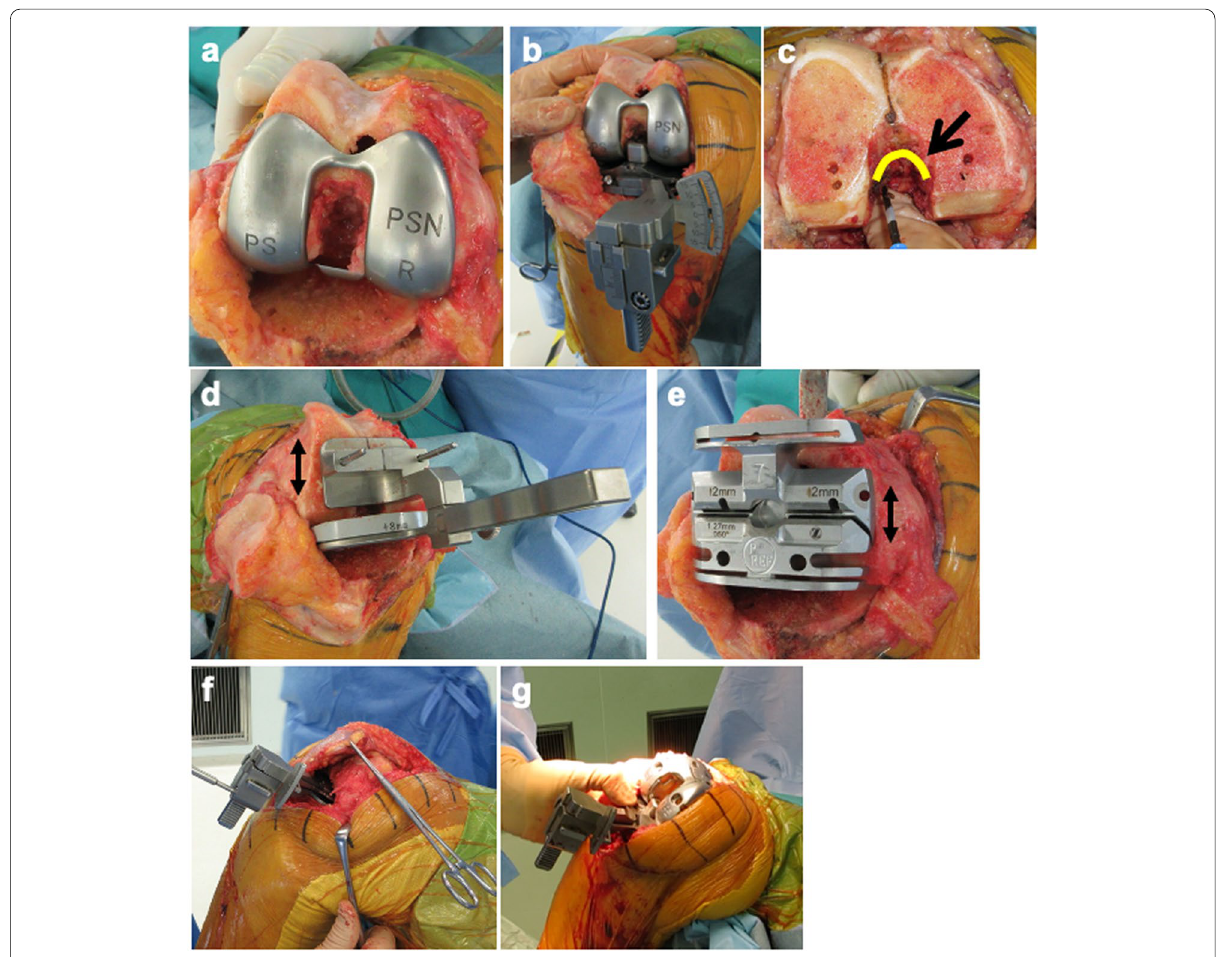
Fig. 3 Surgical procedures. The PS PCT was attached to the femur ( a ), and the component gaps (CGs) by PS PCT were assessed at knee extension and flexion using the Offset Repo-Tensor ® (OFR tensor) ( b ). Release around the intercondylar notch was performed by electrosurgical knife ( c ). In cases in which the flexion gaps were larger than the extension gaps, a small amount of resection of the posterior femoral condyle (less than component thickness; additional resection of < 5 mm) was performed to decrease the flexion gap by moving the drill hole posteriorly ( d ). The final cutting device was placed in the drill hole ( e ). After final bone resection, bone gaps (BGs) were measured ( f ), and final CGs with the trial femoral components after creation of the intercondylar box for post-cam structure were measured at knee extension and flexion ( g ). PS